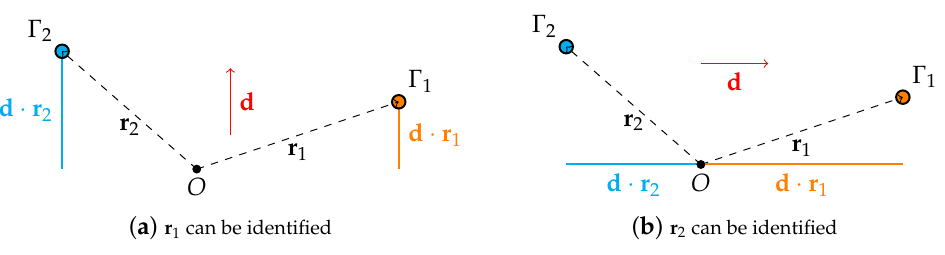
Figure 1. (Remark 2) Illustration of identifiable locations through the map of F MDSM ( x , k 1 , k F , F )